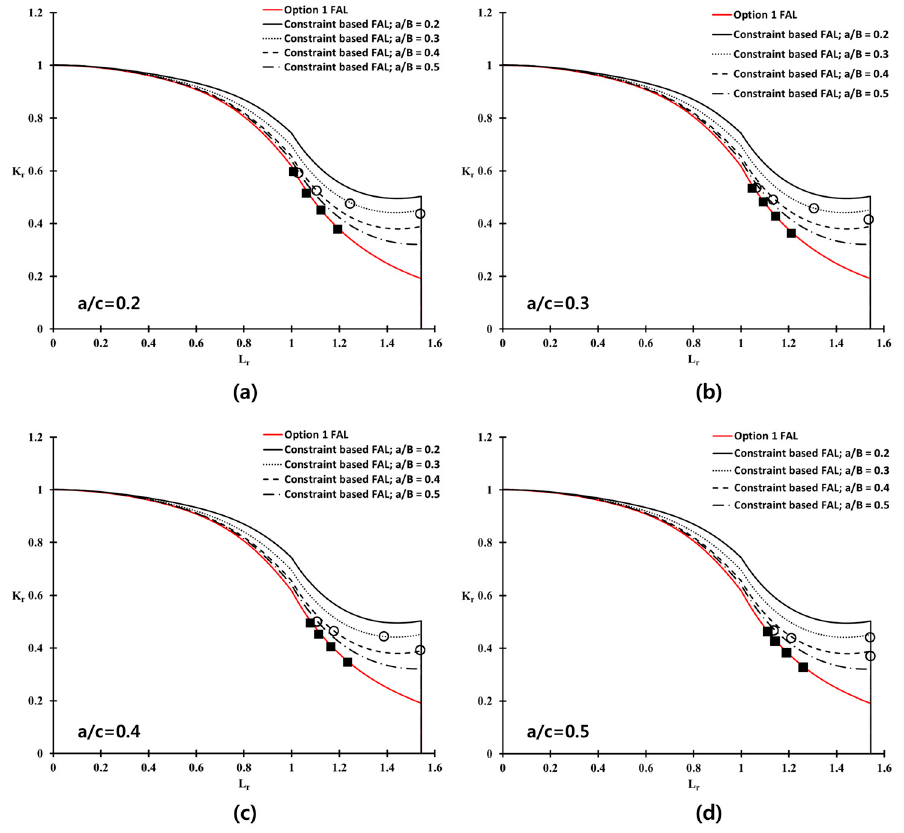
Figure 14. Failure assessment points for the welded plate of Al-5083 based on BS 7910 Option 1 and the constraint-corrected FADs, with different crack configurations ( a ) a/c = 0.2; ( b ) a/c = 0.3; ( c ) a/c = 0.4; and ( d ) a/c = 0.5.